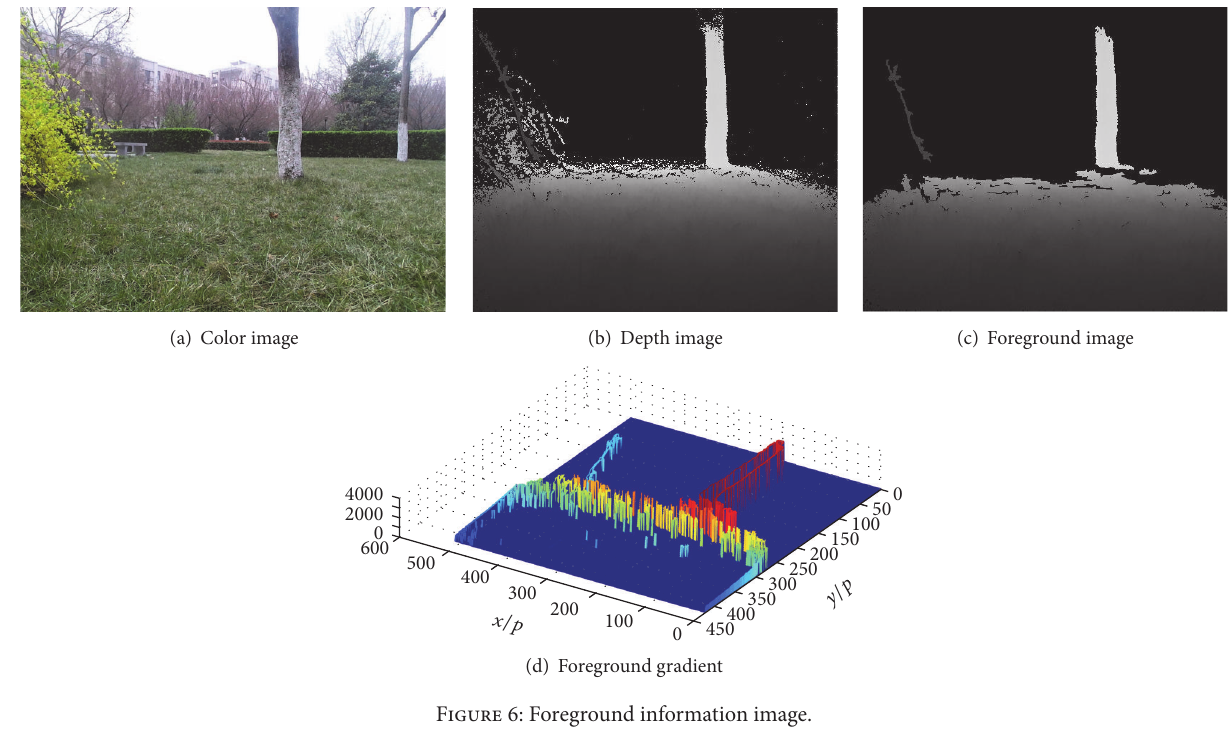
Figure 6: Foreground information